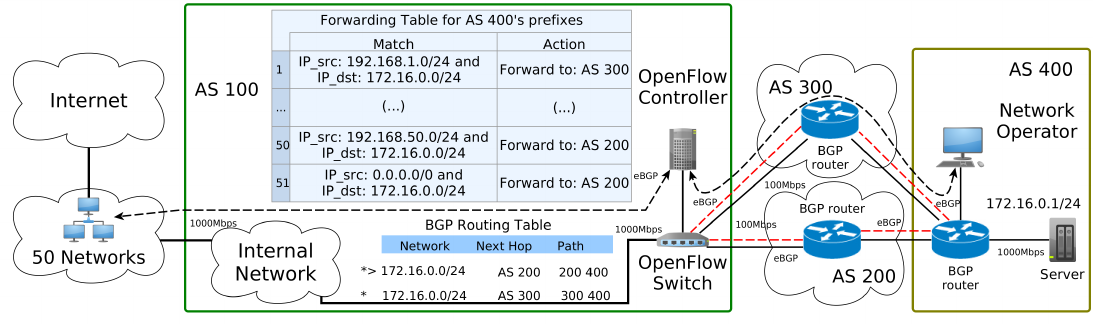
Figure 5. The topology